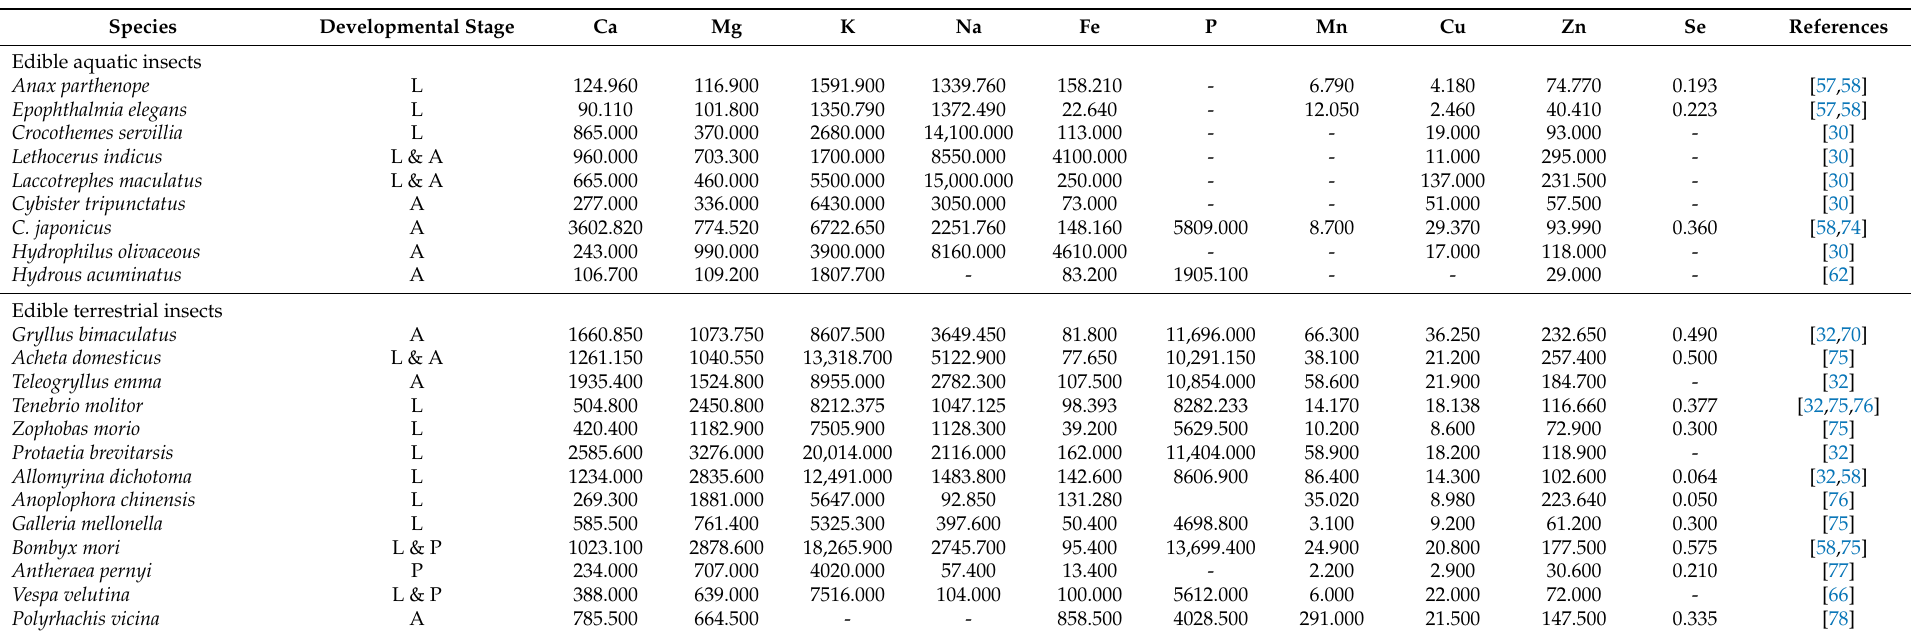
Table 4. Mineral content [mg/kg, DM] of selected edible aquatic insects and edible terrestrial